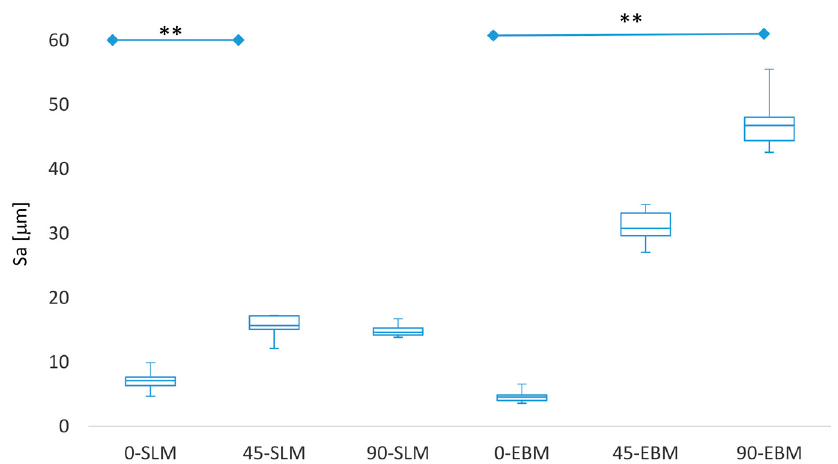
Figure 3. Measured Sa values for the specimens (SLM, EBM) illustrated with a box plot. The figure indicates the median values, the interquartile range and the outlier values ( n = 5). The IQR represents the interval between the 25th and 75th percentile with a blue box. The bars at the top of the figure indicate the statistical significance differences (significance level ** p < 0.01; Kruskal–Wallis test with Dunn’s post-hoc test) between the